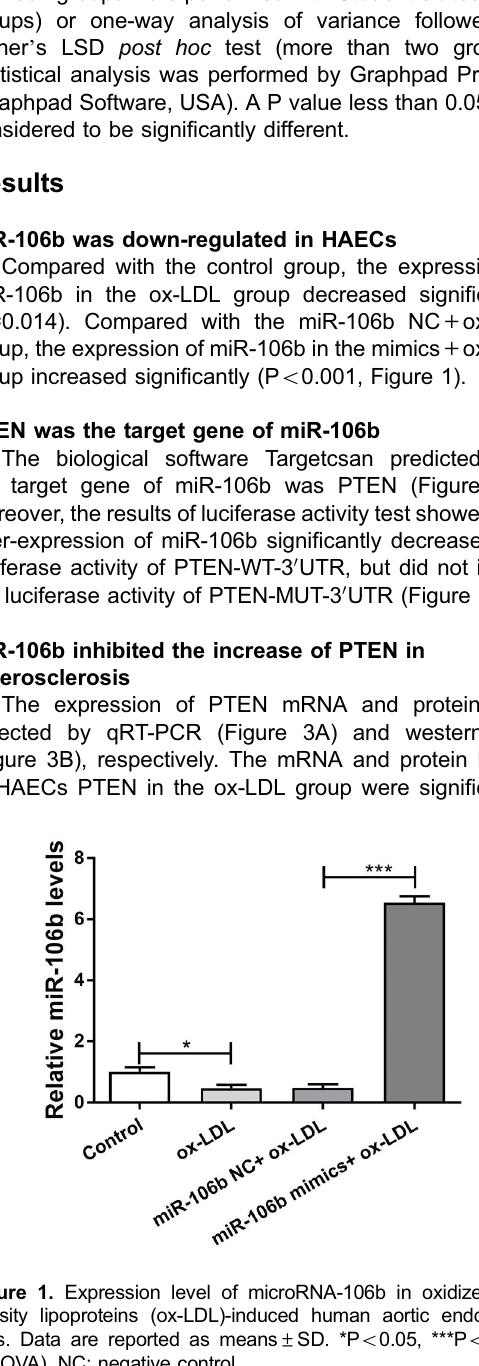
Braz J Med Biol Res | doi: